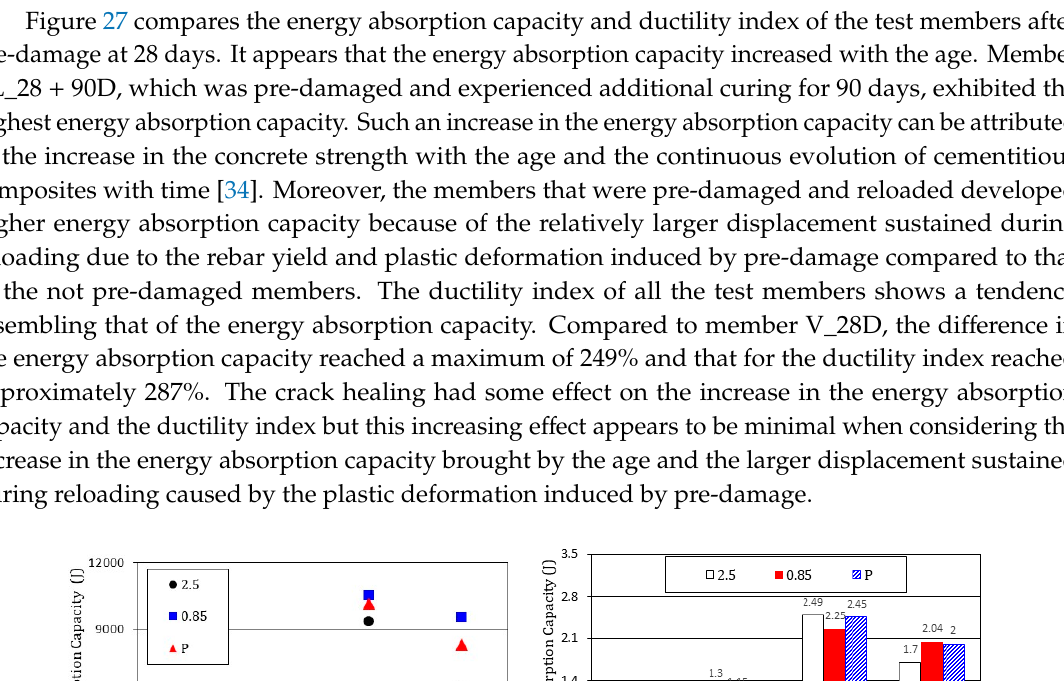
Figure 26. Comparison of reinforcement yield load and members’ ultimate load: ( a ) yield load of steel reinforcement; ( b ) ultimate load of test members.